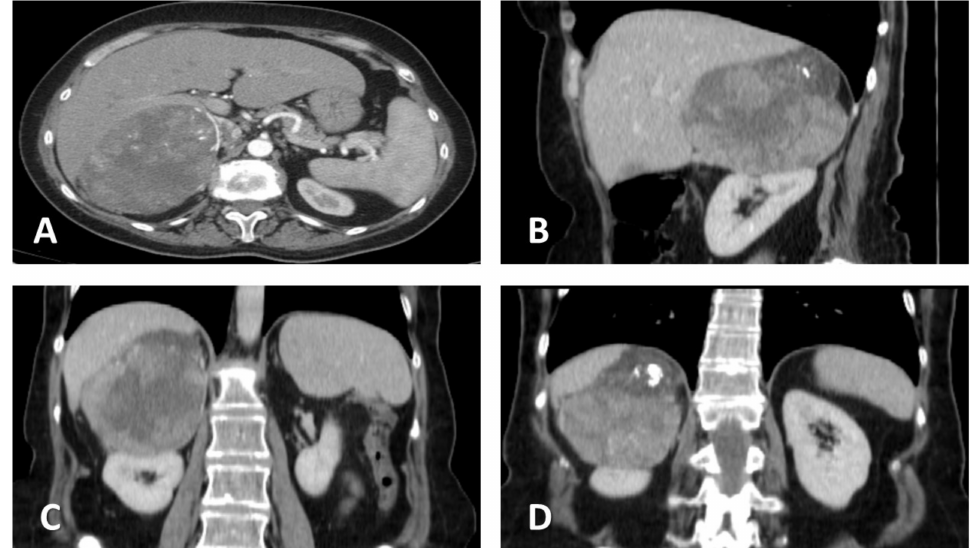
Figure 1. Contrast-enhanced abdominal computer tomography. ( A ) Transversal plane, showing the close contact of the tumor with the right hepatic lobe. ( B ) Sagittal plane. ( C ) Coronal plane, showing possible hepatic and renal invasion, as well as central necrosis. ( D ) Coronal plane, illustrating upper tumoral calcification and suspected invasion of the